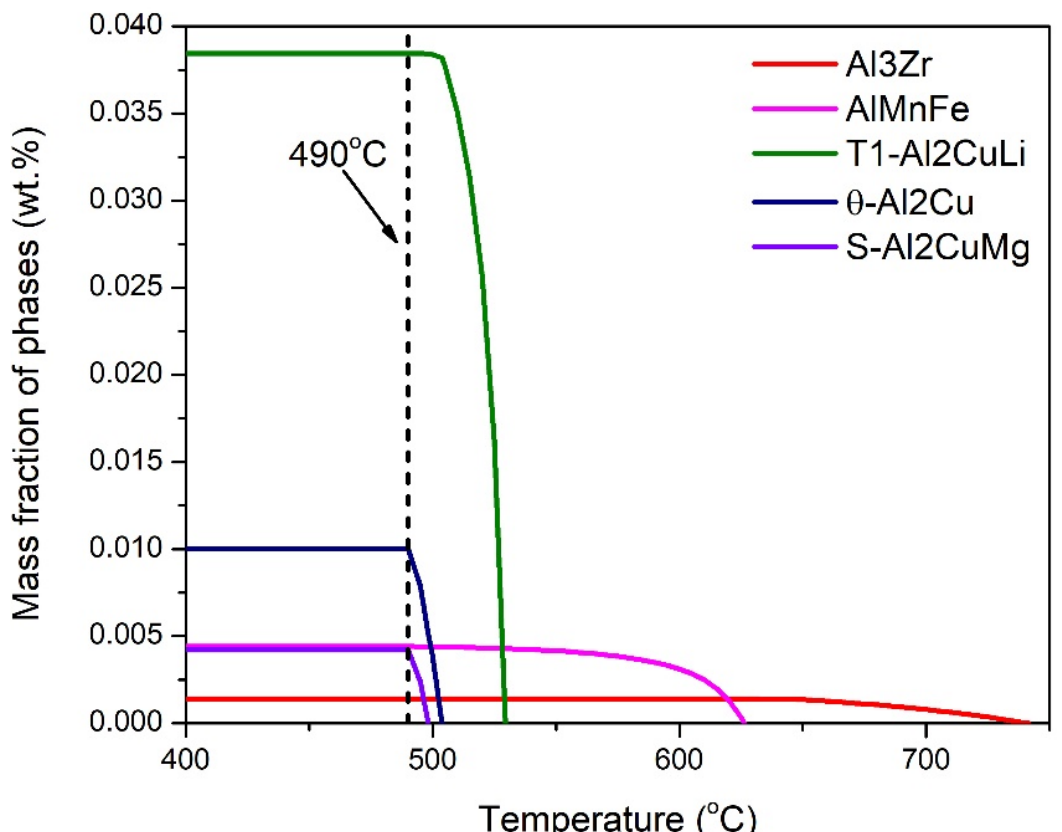
Figure 3. The solidification phase diagram of 2A97 (local amplification).